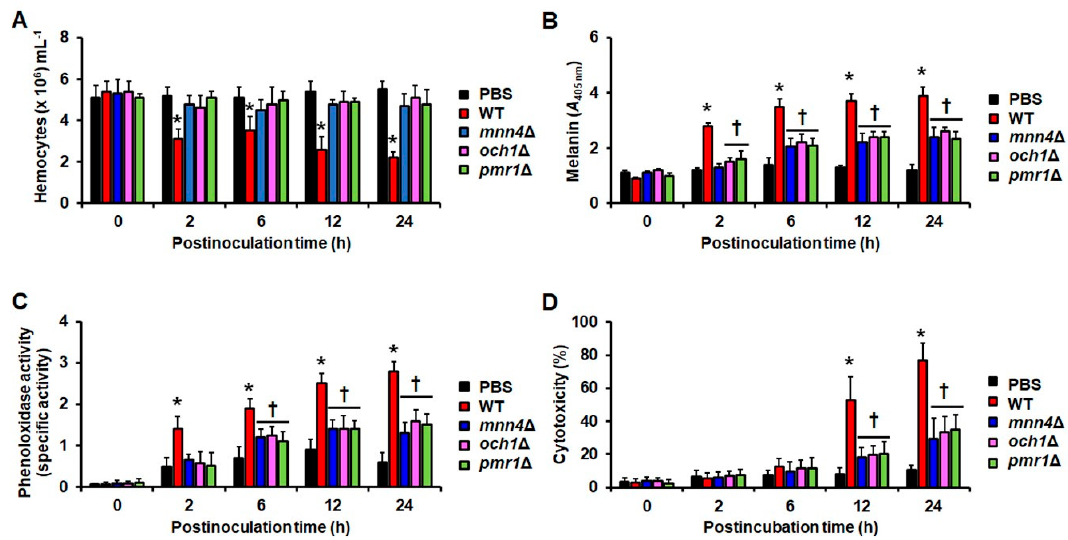
Figure 2. Quantification of hemocytes, melanin, phenoloxidase activity, and cytotoxicity in Galleria mellonella larvae infected with Candida tropicalis WT, mnn4 ∆ , pmr1 ∆ , or och1 ∆ null mutant strains. Groups of 10 animals were infected with 2 × 10 7 yeast cells, incubated for the indicated time at 37 ◦ C, animals were decapitated, hemolymph collected and used to quantify the hemocytes concentration ( A ), melanin production ( B ), phenoloxidase activity ( C ), or cytotoxicity ( D ). In C, the specific activity was defined as the change in the absorbance at 490 nm per one minute per one µ g protein. In D, cytotoxicity was measured as the lactate dehydrogenase activity in the cell-free hemolymph. The 100% cytotoxicity corresponds to the enzyme activity quantified from lysed hemocytes. Strains used are MYA-3404 (WT), HMY175 ( mnn4 ∆ ), HMY181 ( och1 ∆ ), and HMY207 ( pmr1 ∆ ). Data are plotted as means ± standard deviation of three independent experiments performed by duplicated. * p < 0.05 when compared to the other values gathered at the same postinoculation time. † p < 0.05 when compared to the control condition at the same postinoculation time.